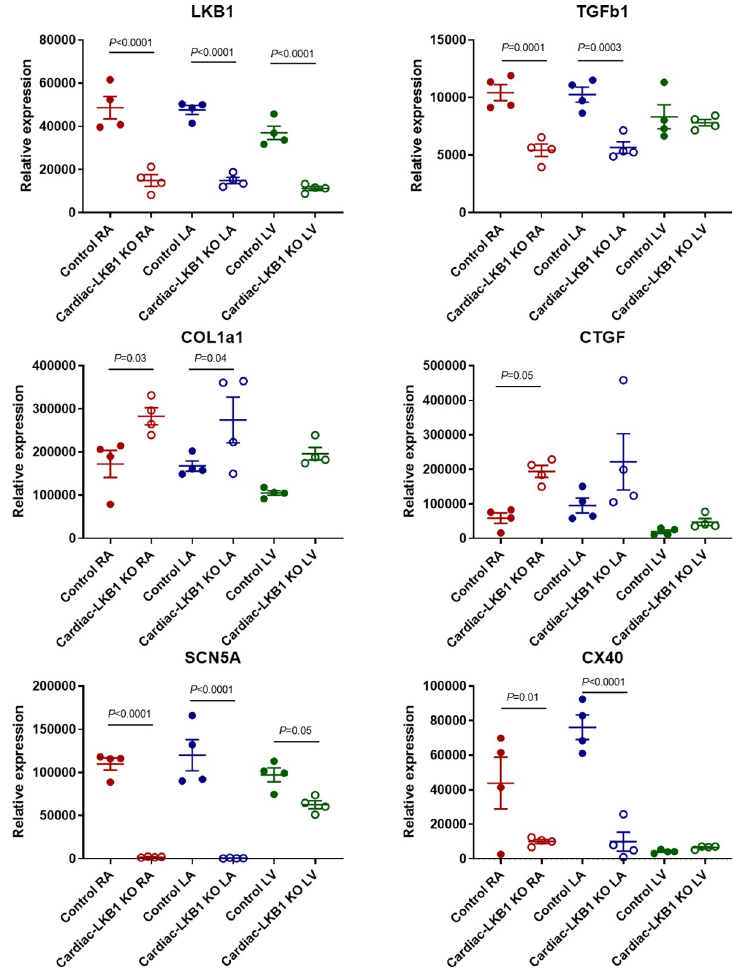
Fig 6. mRNA expression level in right atria, left atria and left ventricles of Cardiac-LKB1 KO and control mice. mRNA expression quantification for LKB1, TGF β 1 (transforming growth factor β 1), COL1a1 (collagen type 1 α 1), CTGF (connective tissue growth factor), SCN5a (voltage gated sodium channel α subunit 5) and CX40 (connexin 40). Each point indicates individual animal data, and lines represent mean ± SEM.